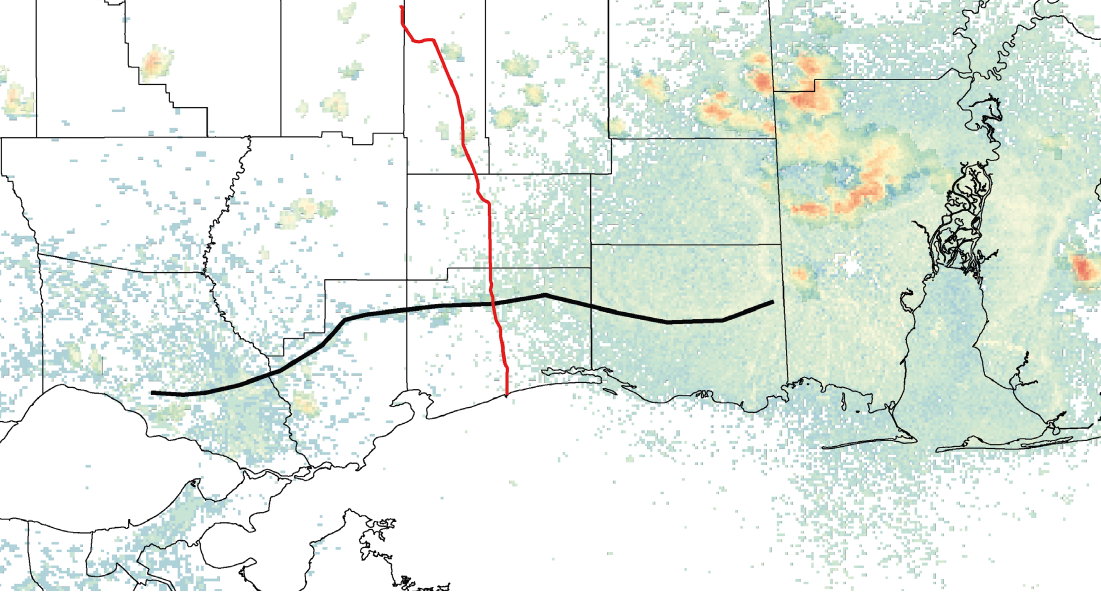
Figure 5: Radar reflectivity from KLIX and KMOB at 2000 UTC on 5 August 2014, with SBF fine line